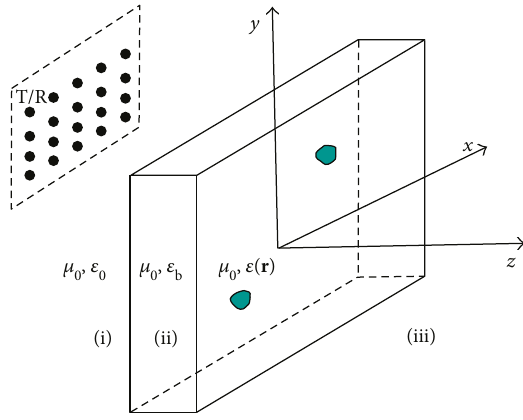
Figure 1: Con fi guration of 3-D intra-wall